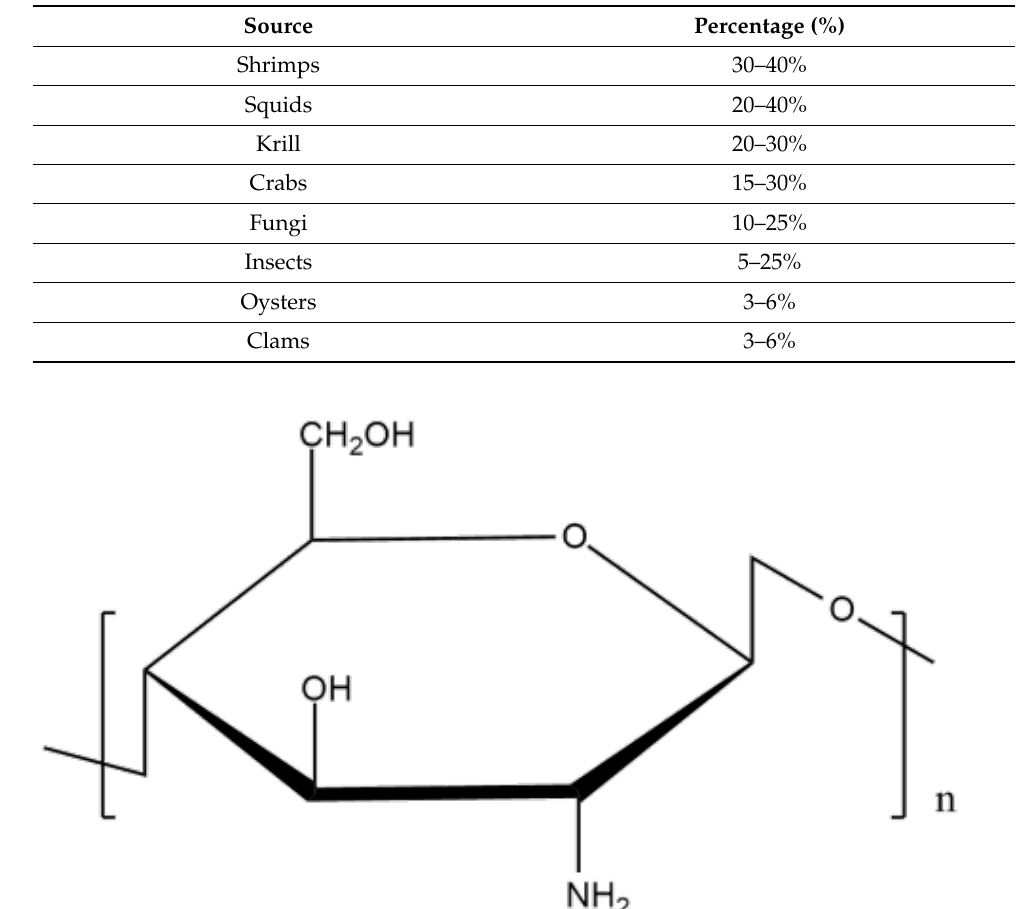
Table 1. Some of the main chitin sources and percentages [13].